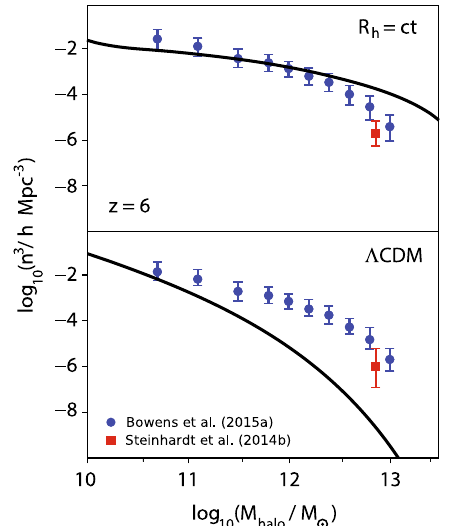
Fig. 3 Top: halo mass function inferred from galaxy surveys at z = 6 compared with R h = ct . Bottom: same, except now for Λ CDM